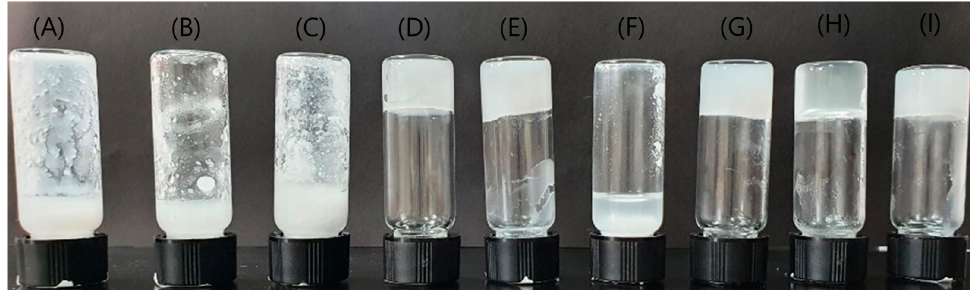
Figure 2. Photograph of supramolecular gels prepared by 1 and 2 in ( A ) DMF, ( B ) DMSO, ( C ) acetonitrile, ( D ) dichloromethane, ( E ) tetrahydrofuran, ( F ) n-hexane, ( G ) chloroform, ( H ) toluene, and ( I )